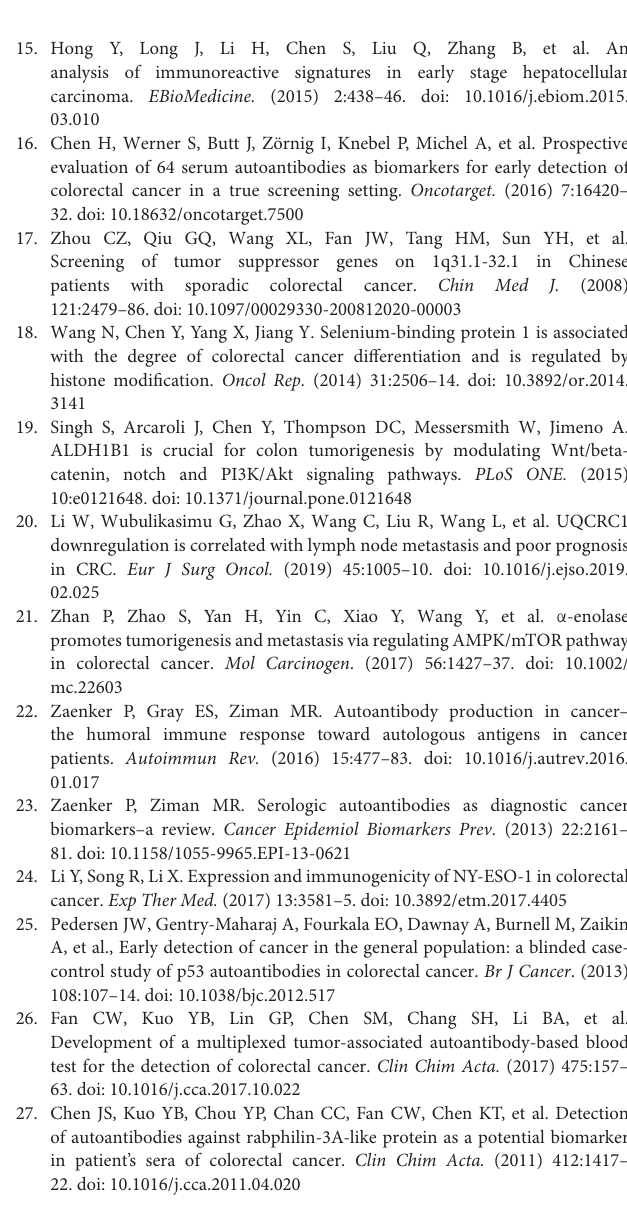
Table S1 | Clinical characteristics of research subjects. Table S2 | Candidatetumour-associated autoantigens applied for microarray analysis identified by serological proteome analysis and MALDI-TOF mass spectrometry. Table S3 | Information about antigen proteins for the preparation of protein microarray. Table S4 | Diagnostic performance of 26 single tumor-associated autoantibodies in the detection of colorectal cancer and advanced adenoma. Table S5 | Comparison of seroprevalence between the autoantibodies and CEA in colorectal cancer at various